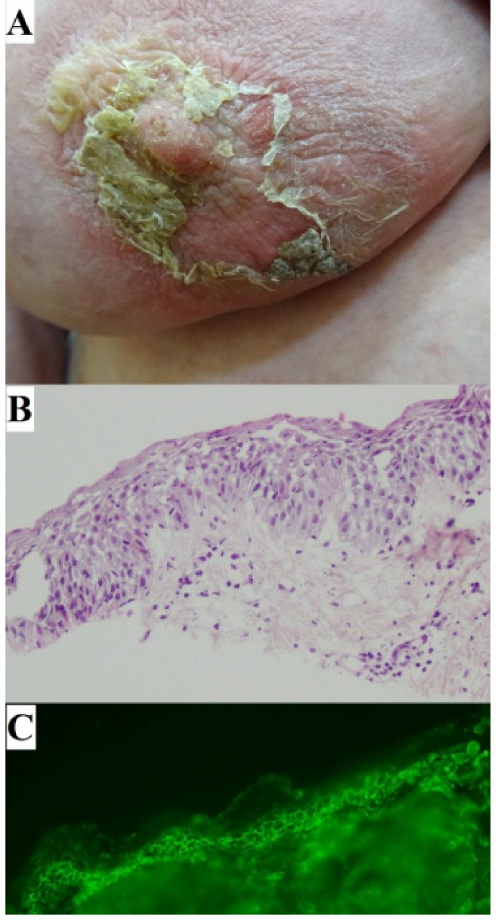
Figure 3. A 63-year-old woman with PV lesions on the right breast around the nipple with impetig- inization ( A ). Acantholytic keratinocytes in the upper epidermis in H + E histology (original objective magnification × 20) ( B ). IgG4 (++) pemphigus deposits revealed with a DIF visualized using a